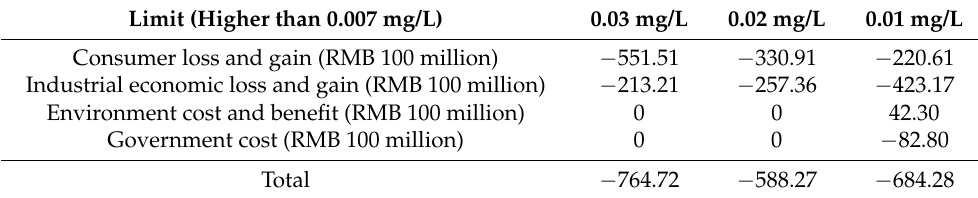
Table 12. Cost–benefit analysis for determination of the general